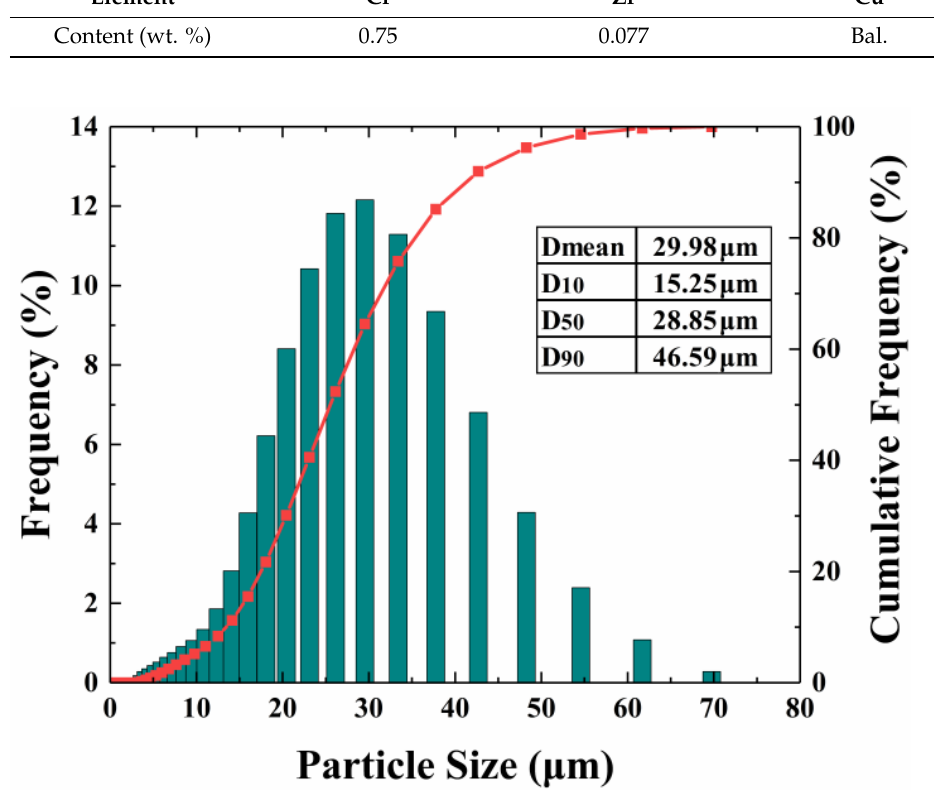
Figure 1. Particle size distribution of CuCrZr powder.